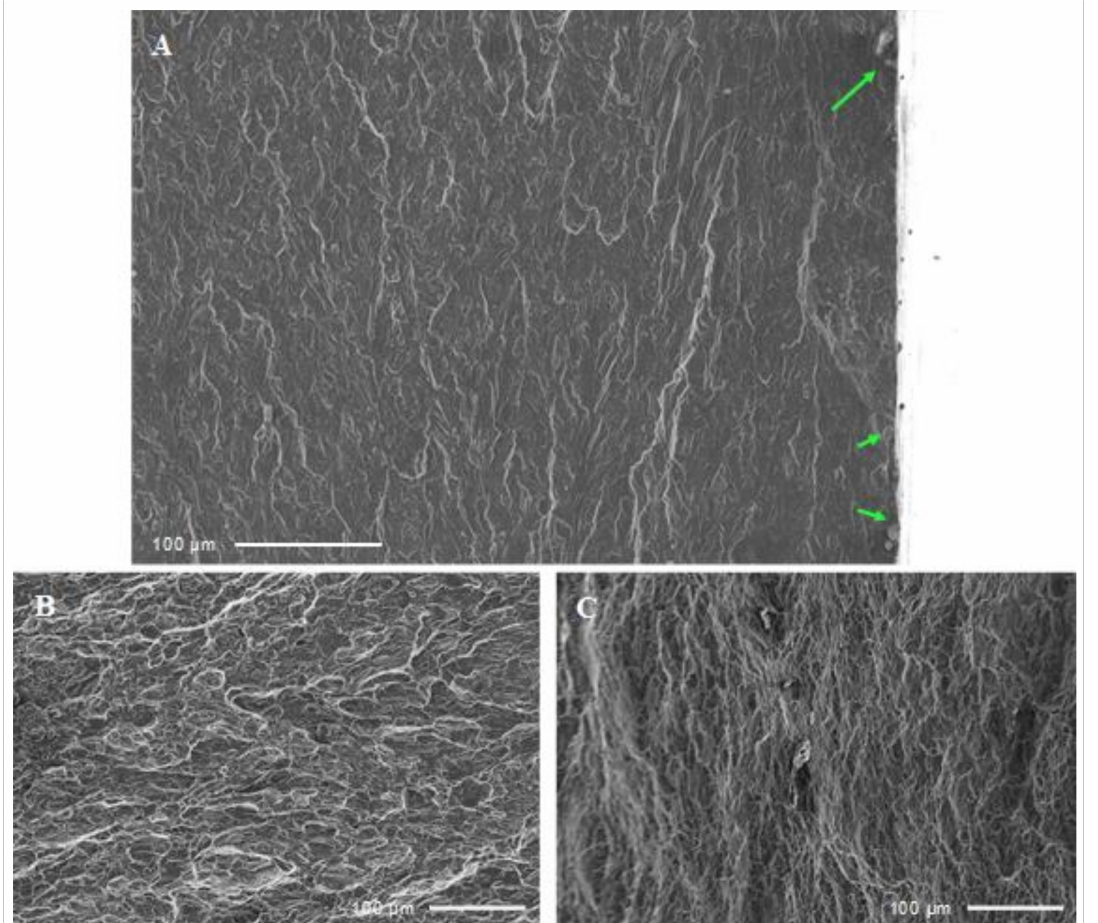
Figure 10. Fatigue fracture morphologies of the polished specimen tested in air at 167.5 MPa. The micrographs ( A – C ) correspond to the three different regions pointed out in Figure